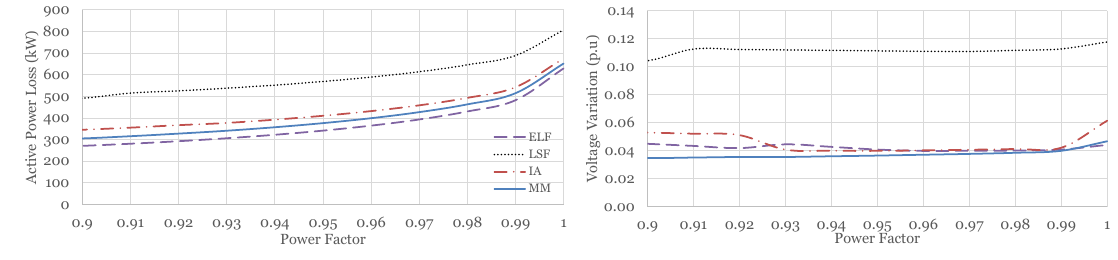
Figure 8. Operational power factor for 37 node system.